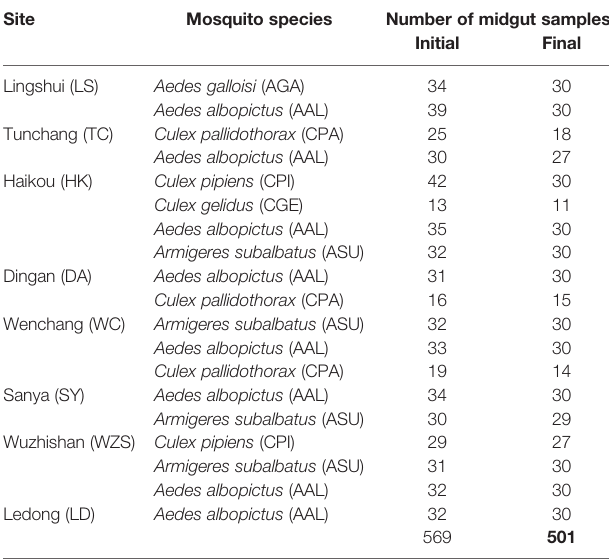
TABLE 1 | Number of mosquito samples processed for midgut bacteria.